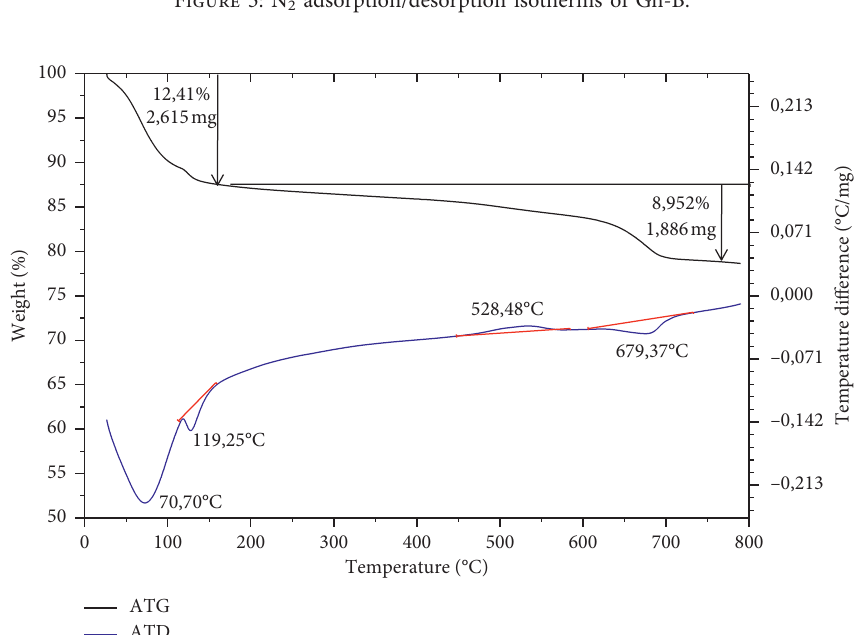
Figure 6: DTA and TGA plots of